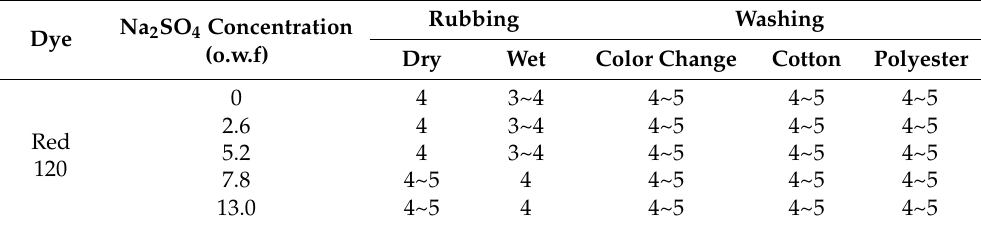
Table 1. Color fastness of dyed fabric.